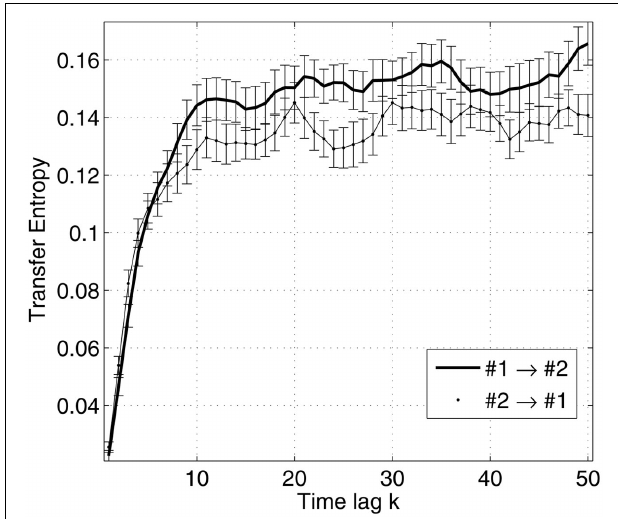
FIGURE 3 |Transfer entropy as a function of the time lag between the future of one signal and the past of the other signal, illustrated for a pair of sources. The sources are taken from the same network for a given subject and condition.The errorbars are specified by the mean and standard error of the estimated measures across